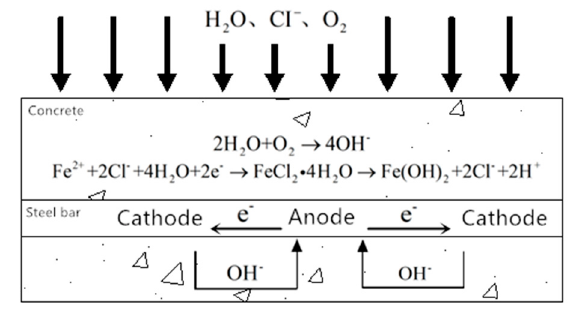
Figure 4. The electrochemical reaction.